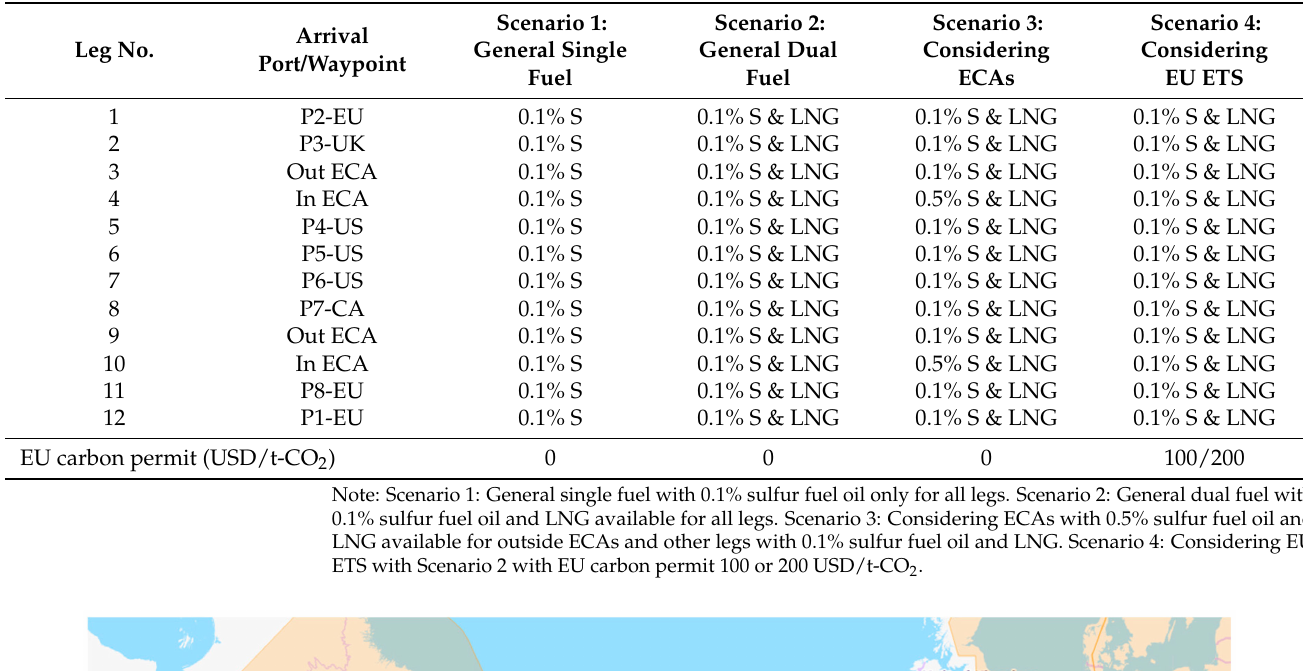
Table 5. Available fuel types in all legs and EU carbon permit costs set in four scenarios.